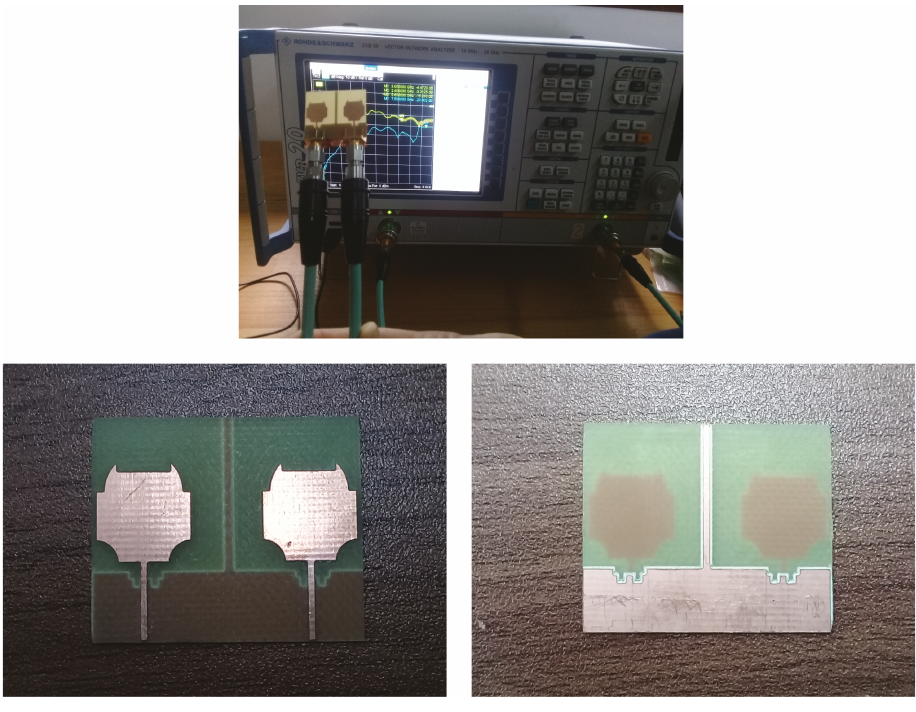
Figure 9: Photographs of the fabricated antenna.